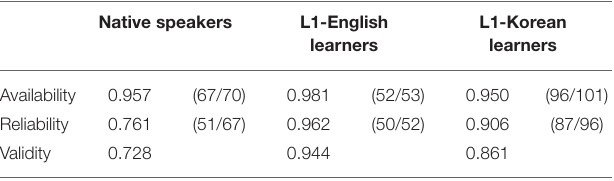
TABLE 4 | Word-order patterns by language group. Native speakers